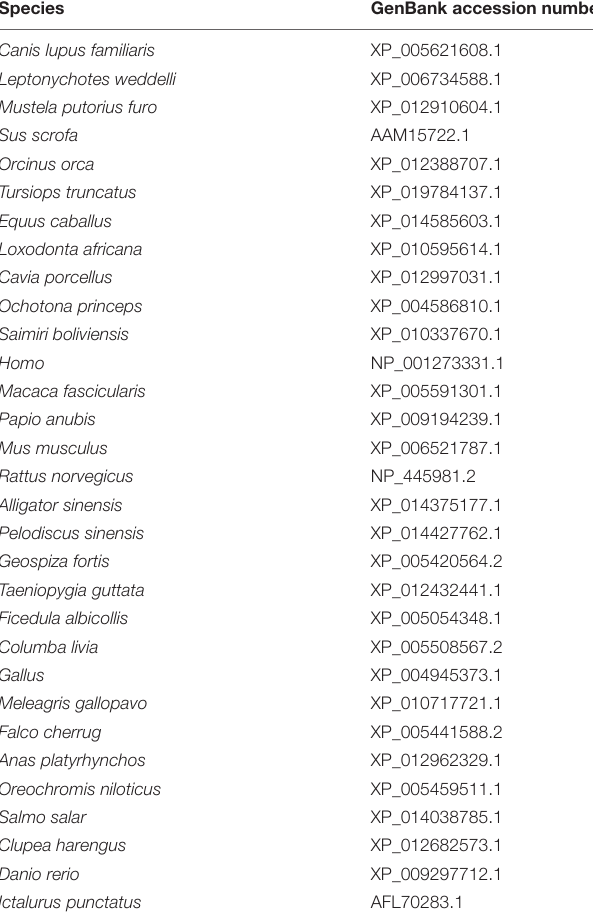
TABLE 2 | Reference sequences